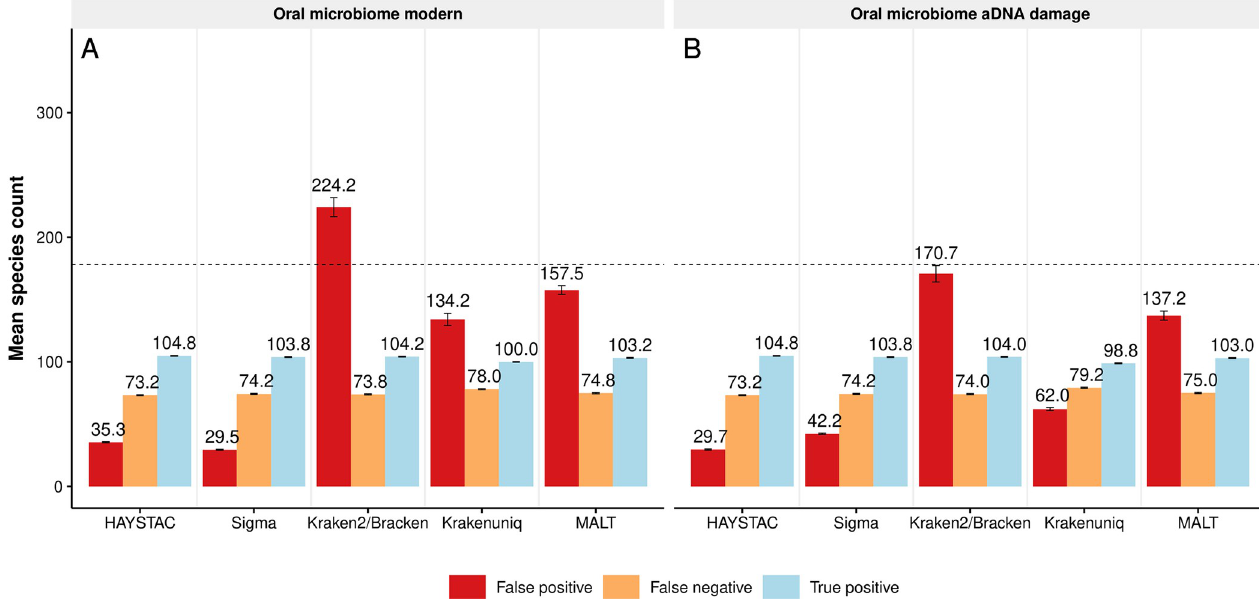
Fig 4. Accuracy of HAYSTAC and other methods for an oral microbiome simulation. Bar plot showing the mean count of false positives (red), false negatives (orange), and true detected species (blue) for two versions of the oral microbiome dataset, each with six replicates: (A) modern simulation, with fixed read lengths ( n = 6); and (B) ancient simulation, with variable read lengths and post-mortem damage ( n = 6). The dotted line shows the average number of simulated species in each set of samples ( i . e .,the maximum true positive; n = 178), and numbers above the error bars indicate the mean species count in each category. For the modern simulation, HAYSTAC substantially outperforms Kraken2/Bracken, KrakenUniq and MALT with respect to false positives, and performs equivalently with Sigma. For the ancient simulation, HAYSTAC outperforms all four other methods with respect to false positives. The overall high rates of false negative identifications are due to the absence of many simulated species from the reference database for all four methods. HAYSTAC also outperforms all the other four methods in both the modern and ancient Oral Microbiome datasets by identifying the highest number of true positive species.